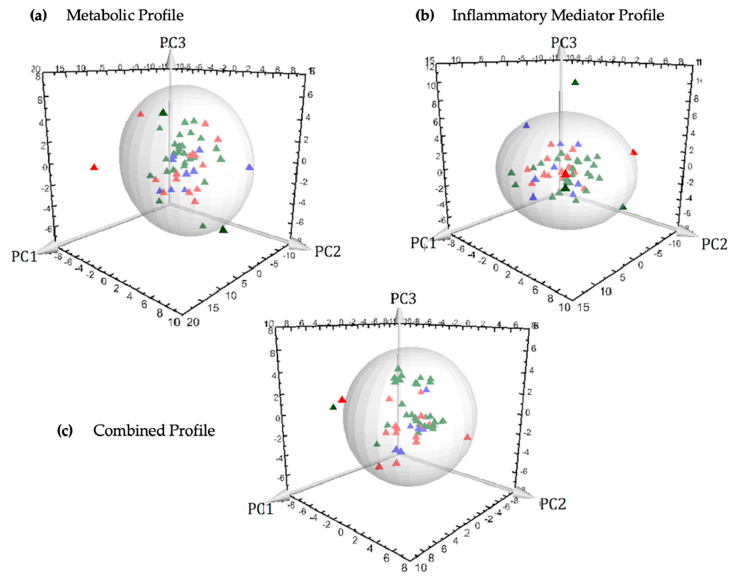
Figure 1. Three-dimensional PCA-X score scatter plots of pediatric patients with appendicitis using ( a ) metabolic profile, ( b ) inflammatory mediator profile, ( c ) combined metabolic and inflammatory mediator profile. Each plot is based on three principal components - PC1, PC2 and PC3. Red diamonds represent distribution of pediatric patients with severe appendicitis, blue diamonds represent patients with moderate appendicitis and green diamonds represent patients with mild appendicitis.